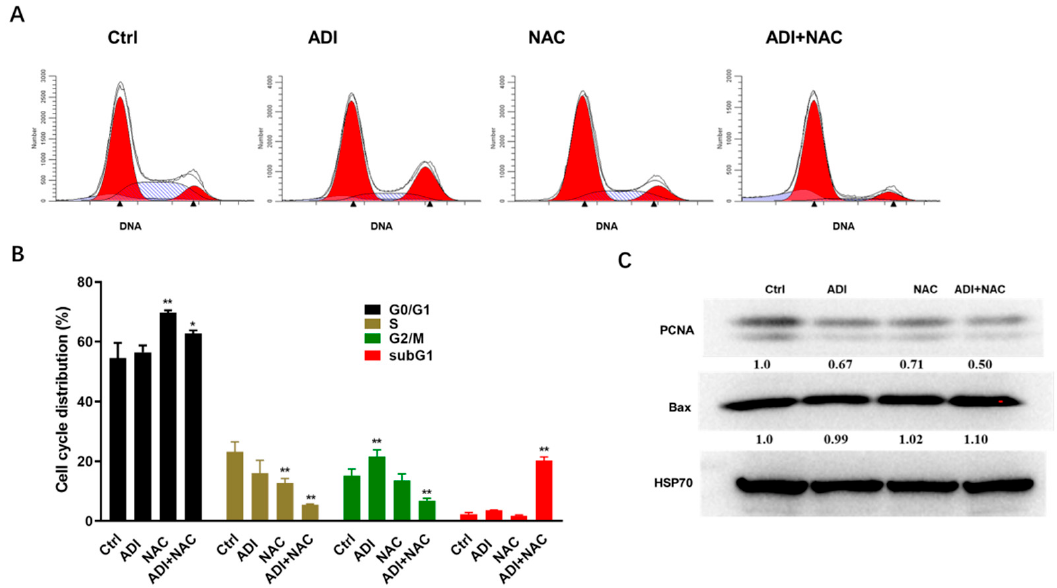
Figure 3. Induction of cell cycle disturbance in MC38 cell lines. ( A ) MC38 cells were treated with ADI-PEG 20 and NAC for 24 h, and then cells were stained with PI to evaluate cell cycle progression. ( B ) The percentages of cells in various cell cycle phases among ADI-PEG 20- and NAC-treated MC38 cells relative to control. Mean values ± SD of three separate experiments performed in triplicate. ( C ) Representative images of immunoblotting analysis of Bax and proliferating cell nuclear antigen (PCNA). * p < 0.5, ** p < 0.01 (comparison to the control).